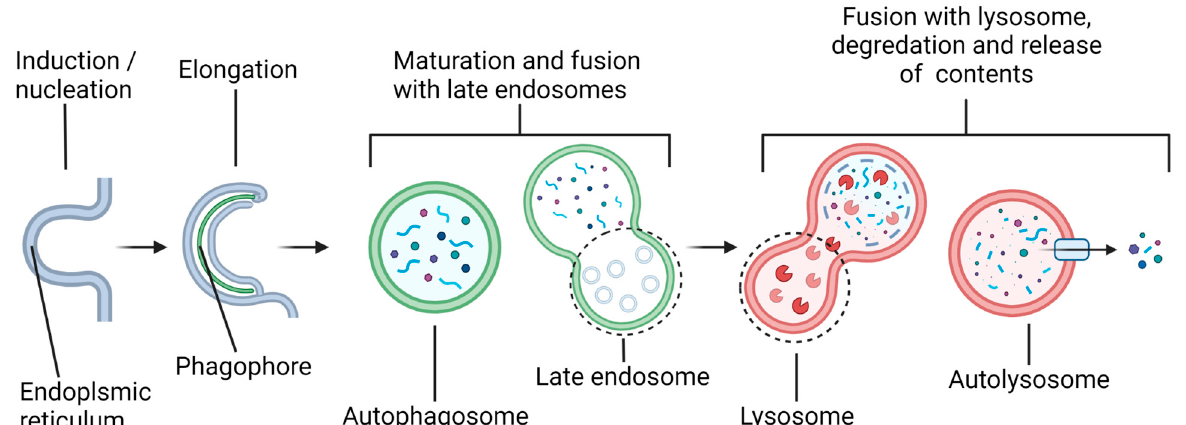
Figure 1. Overview of the autophagy pathway. Induction of autophagy begins with the formation of a cup-shaped domain of the endoplasmic reticulum called an omegasome. The nascent autophagosome, called a phagophore or induction membrane, is formed from the omegasome, and it grows until it has sealed around its cargo and produced a mature autophagosome. The autophagosome subsequently fuses with a late endosome, also known as multivesicular bodies (MVBs), ultimately merging with a lysosome or lysosomes. Acid hydrolases in the lysosome degrade the inner autophagosomal membrane and its contents into the cellular building blocks, which, afterwards, are released into the cytosol for recycling in the cell.